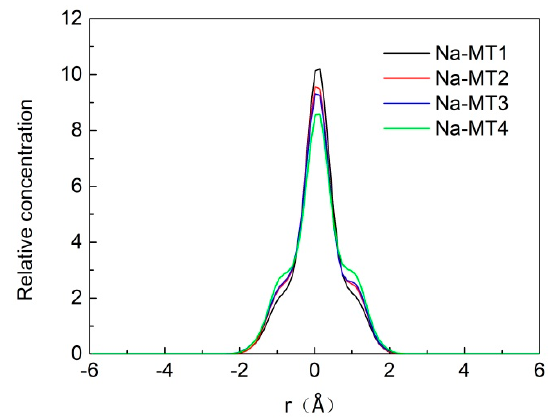
Figure 3. The z-axis concentration curves of H 2 O in interlayer of Na-MT with different layer charge density.